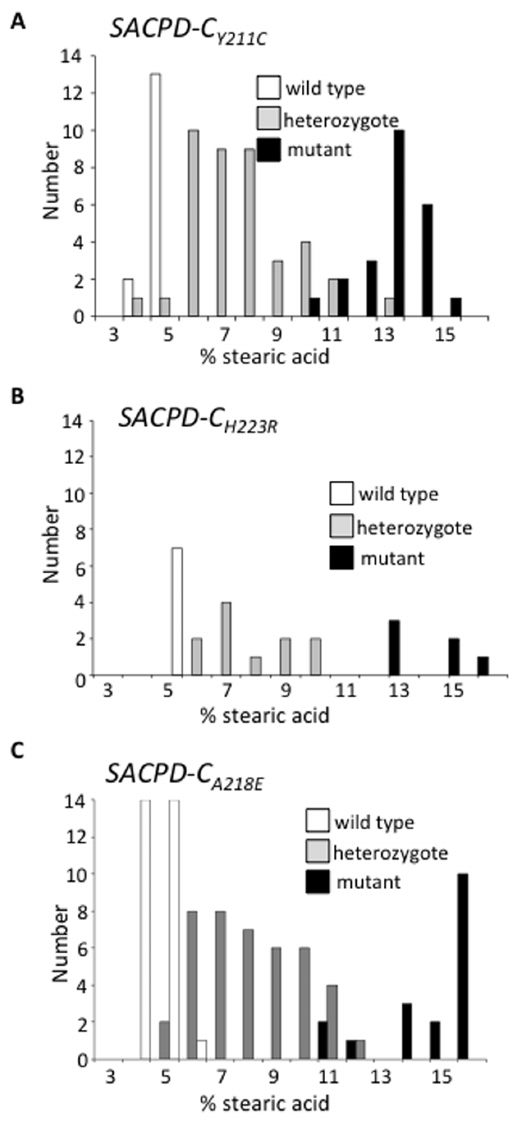
Figure 2. Cosegregation of SACPD-C mutations and elevated stearic acid phenotype. Individuals from segregating populations were analyzed for stearic acid content and genotyped for A. SACPD- C Y211C (78 indivduals) B. SACPD-C H223R (24 individuals), and C. SACPD- C A218E (89 individuals). White bars indicate wild-type individuals, grey bars indicate heterozygous individuals, and black bars indicate homozygous